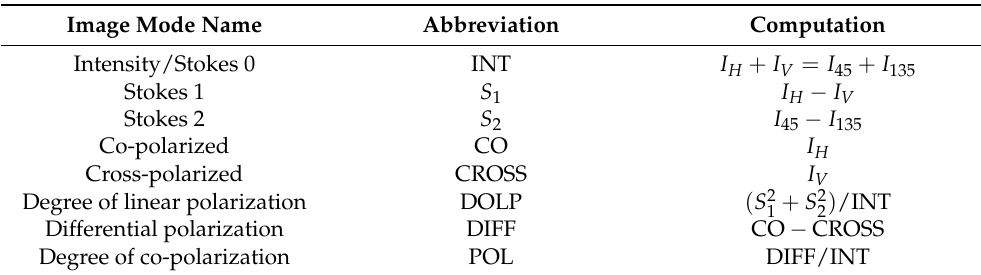
Table 4. Imaging modes used in this study. From left to right: name, abbreviation used in this article, and means of obtaining them using the raw images (see Table